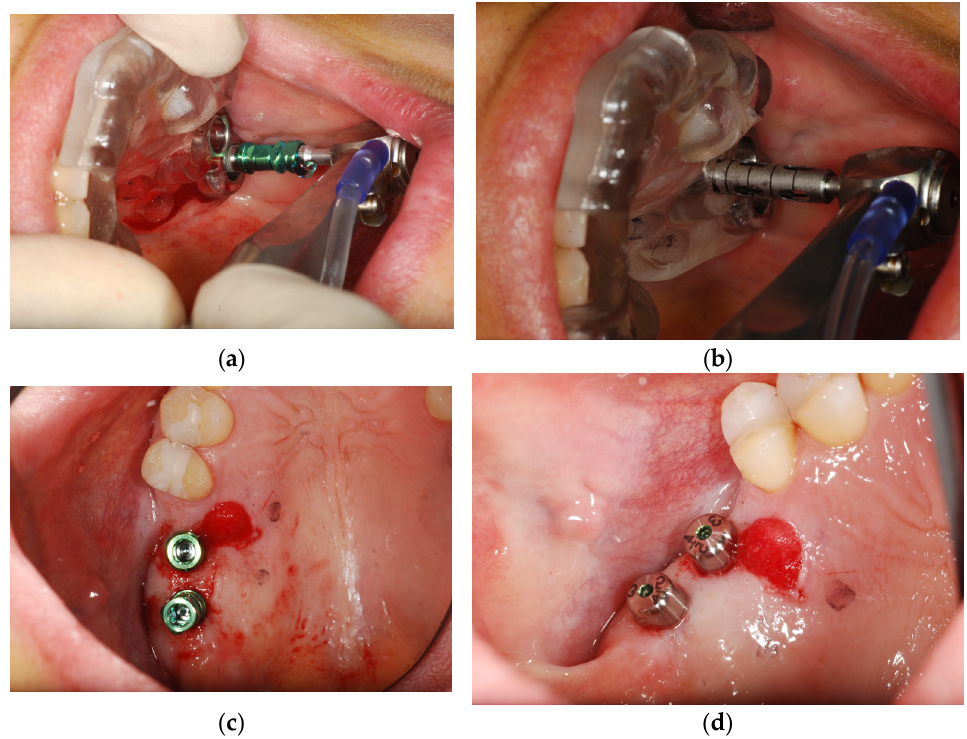
Figure 5. Oral surgery: ( a ) placement of implants; ( b ) bone biopsy; ( c ) occlusal view after implants’ placement and osteotomy; ( d ) final view, with healing screws placed.